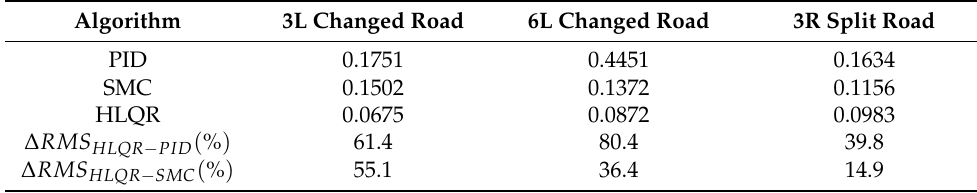
Table 2. Comparison of the slip ratio RMS controlled by PID, SMC, and HLQR.